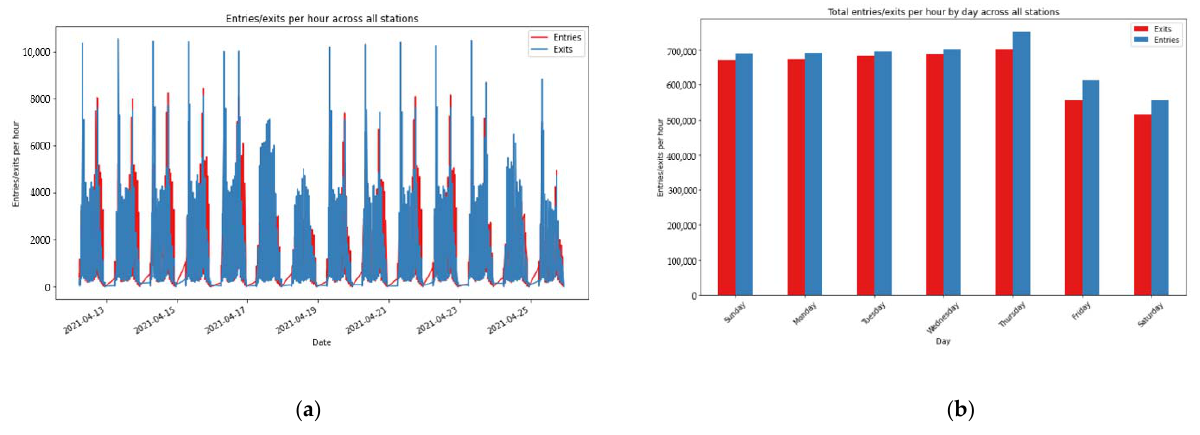
Figure 9. Influence of date attribute on URT passenger flow. ( a ) Daily inbound/outbound passenger flow statistics; ( b ) Statistics of daily average inbound/outbound passenger flow within a week.